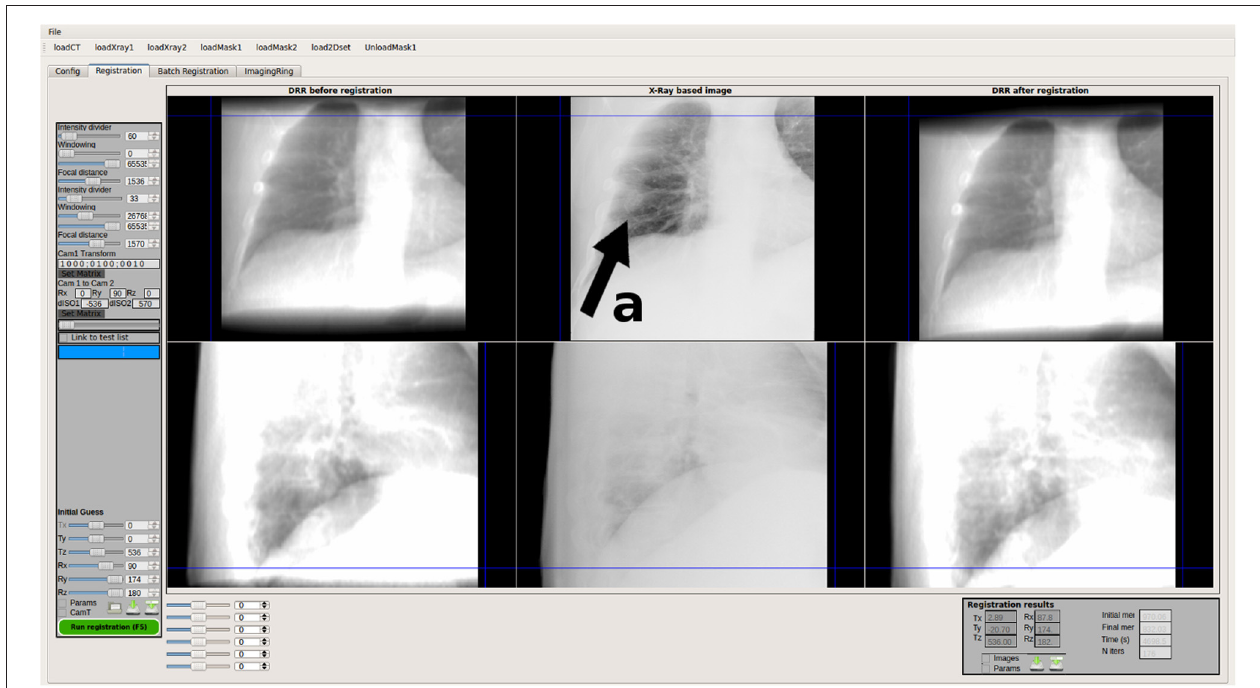
FIGURE 6 | User interface of FIRE, a research grade software for real-time 2D/3D image registration in fractionated external radiation therapy. The position of the patient as well as intrafractional tumor motion—in this case caused by lung motion—is measured using simulated digitally rendered radiographs and calibrated X-ray and electronic portal imaging data. The upper row represents the x-ray data from the LINAC mounted digital x-ray source (the tumor is indicated by arrow a in this case), and the lower row shows a comparison of an artificial x-ray image rendered from CT compared to a low-contrast electronic portal image taken with the therapy beam